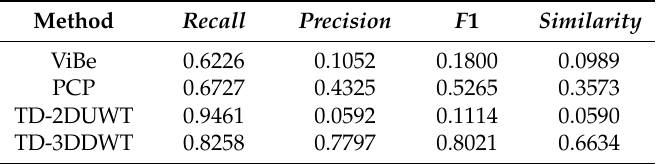
Table 8. Comparison of average metrics for the two-position PTZ camera